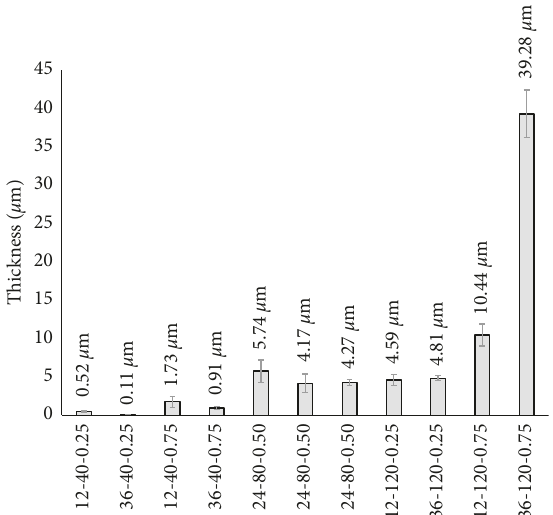
Figure 6: The thickness of the sodium niobate layer measured at each synthesis conditions and the respective standard deviations.